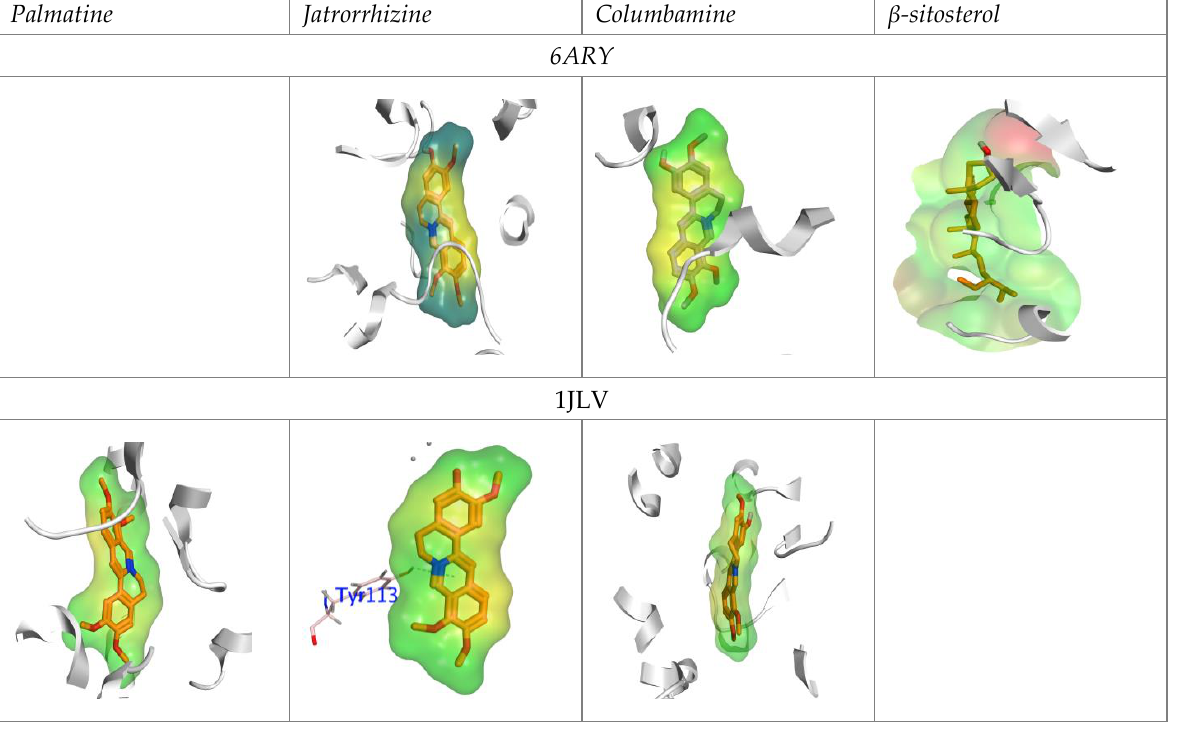
Figure 8. The hydrophobic interaction map for the isolated compounds into the active sites of the AChE and GST domains.